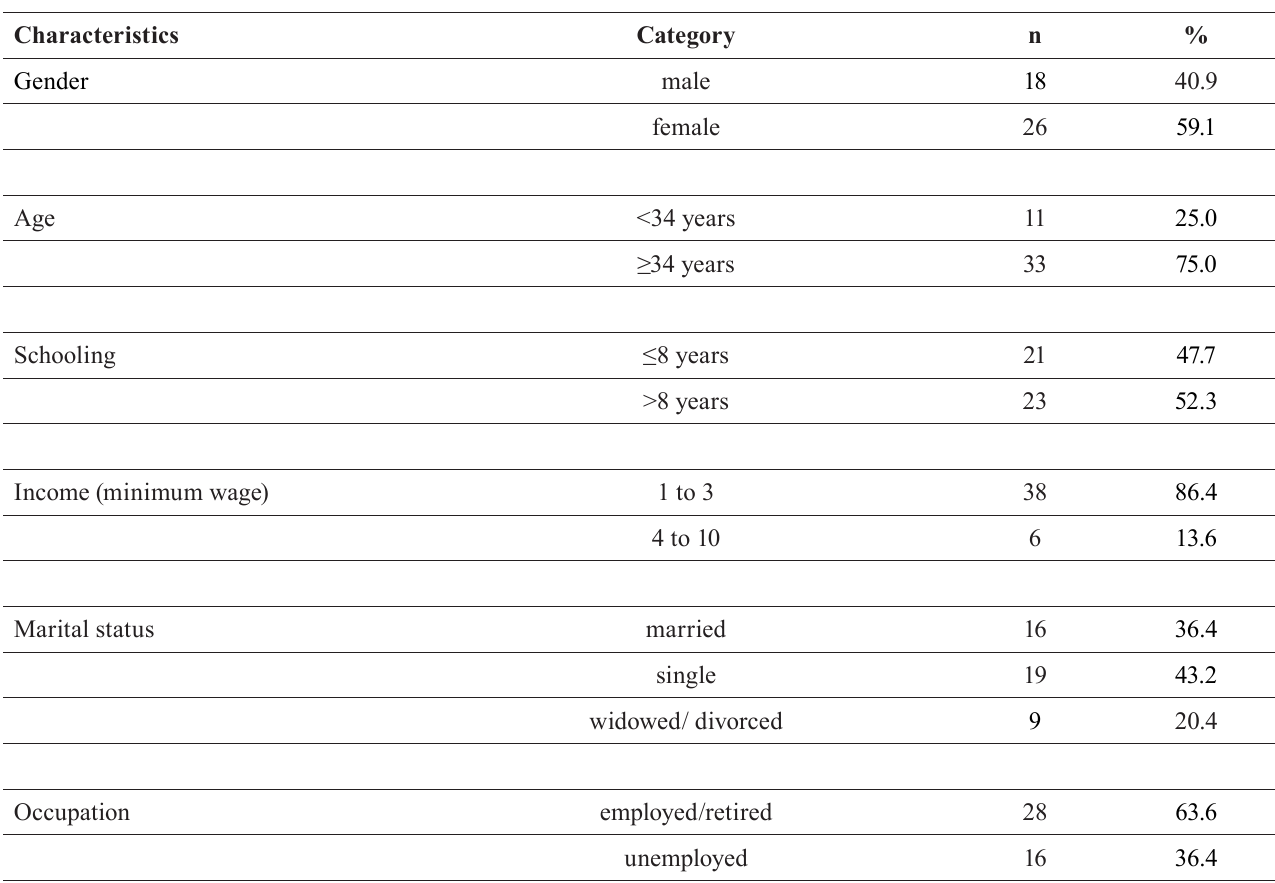
TABLE I - S ociodemographic characteristics of HAART patients